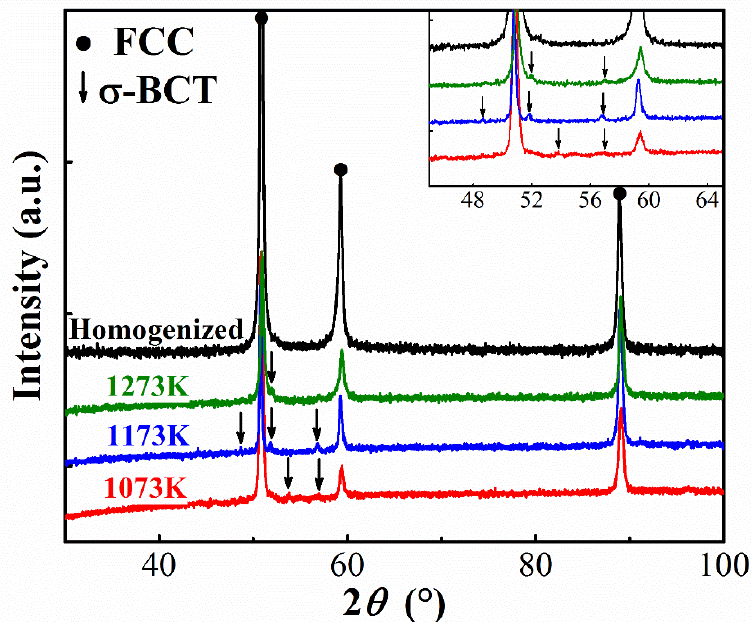
Figure 1. The XRD patterns of Fe 50 Mn 20 Cr 20 Ni 10 MEA with different annealing states (including the homogenized sample).